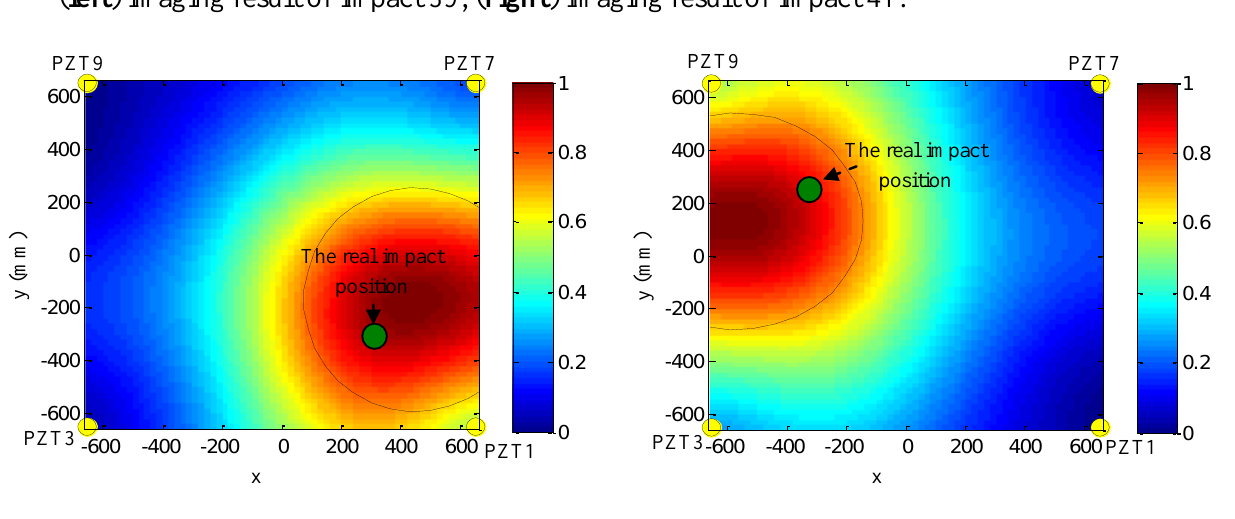
Figure 17. Typical impact alarm region imaging results of impact monitoring region 2: ( left ) imaging result of impact 44; ( right ) imaging result of impact